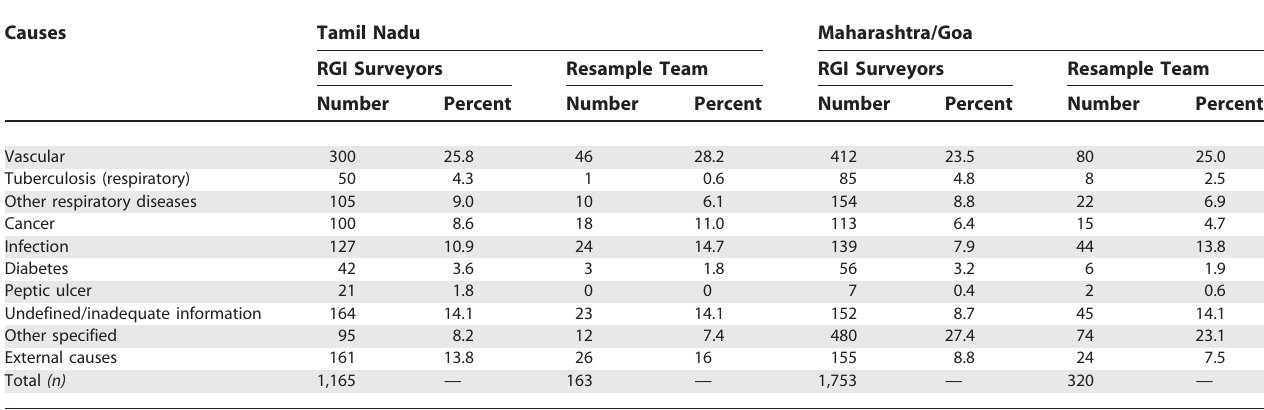
Table 3. Cause of Death Results for RGI Surveyors and Resample Teams in Tamil Nadu, Maharashtra, and Goa Using VA (Deaths . 28 d) in 2003